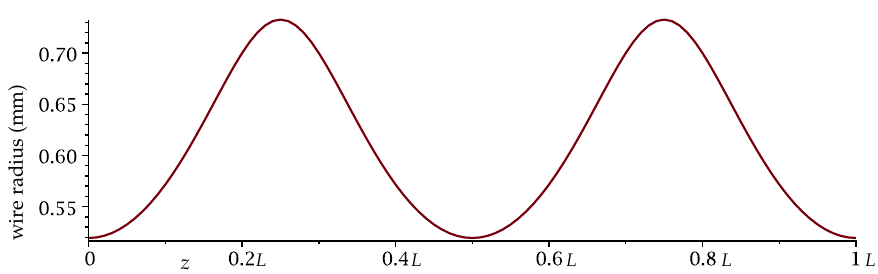
Figure 7. By combining our desired field profile (the Mathieu function of (1)) with the plasma frequency response in Figure 6 we can predict the necessary radius variation for our 4 × 4 wire array in a waveguide. The result is shown here, with a radius that changes by about ± 15% around its average value.